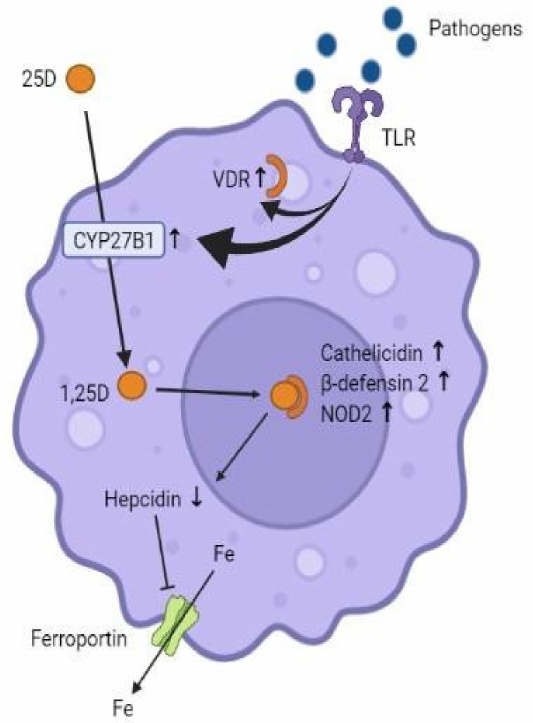
Figure 1. Effects of vitamin D on immune cells. Activation of toll-like receptors (TLRs) by pathogens increases the expression of VDR and CYP27B1. 1,25(OH)2D3 binds to VDR, which induces the formation of cathelicidin, β -defensin 2 and NOD2. Vitamin D suppresses hepcidin, which facilitates the outflow of intracellular iron